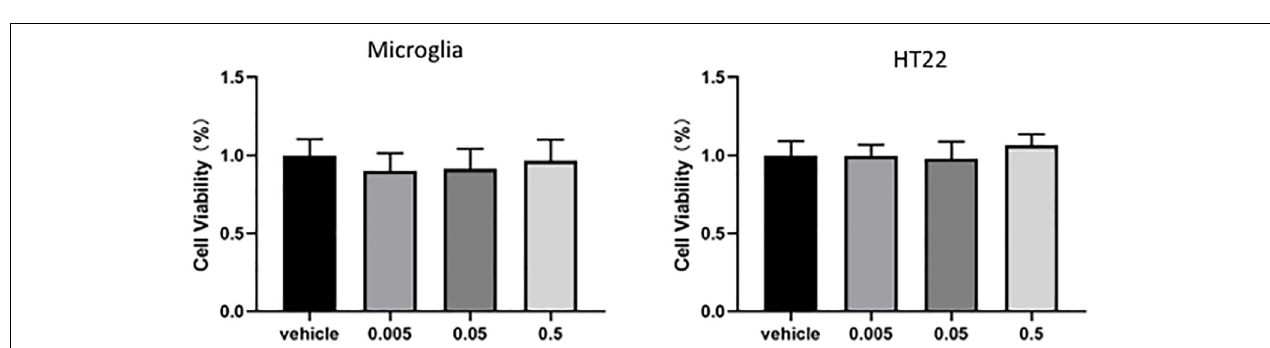
FIGURE 7 | In vitro cytotoxicity analysis. There was no significant difference in cell proliferation after treatment with different concentrations MaR1 both in HT22 and in microglia